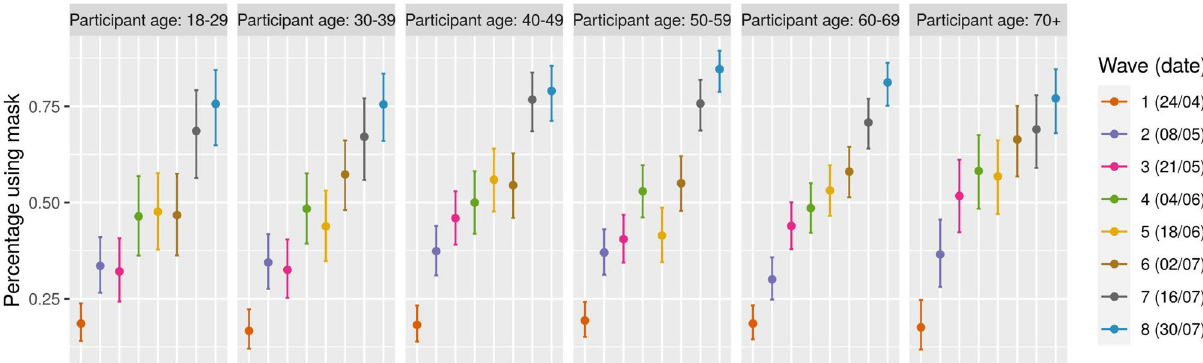
Figure 5. Percentage of participants using face mask. Average number of participants wearing mask broken down by age. Errorbars mark the 95%